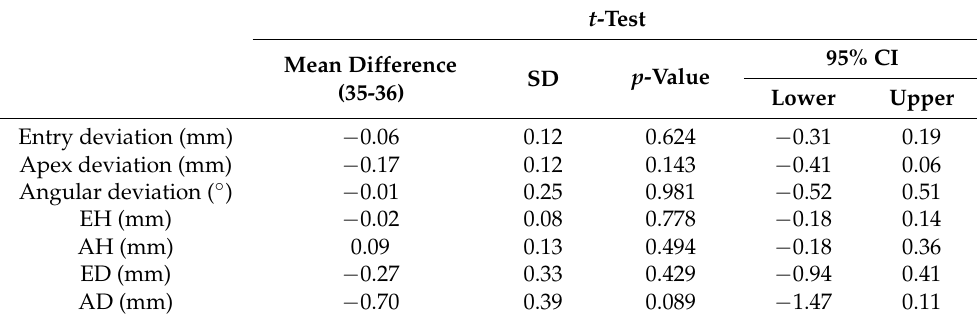
Table 4. Difference of implant position deviations between different tooth positions (tooth no. 35 and tooth no. 36) at the free-end